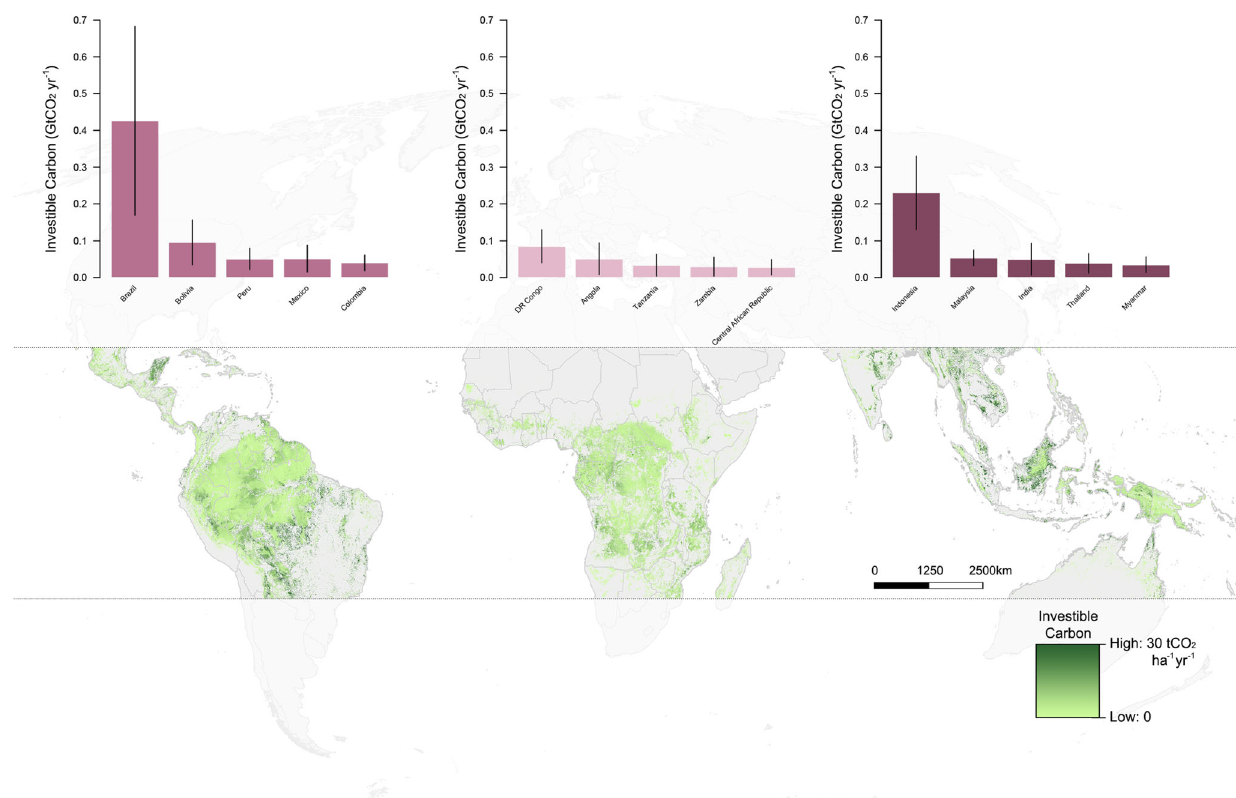
Fig. 1 Global investible forest carbon across the tropics. The estimated volume of investible carbon from the fi ve countries with the highest potential in each of the tropical regions of the Americas, Africa, and Asia-Paci fi c are